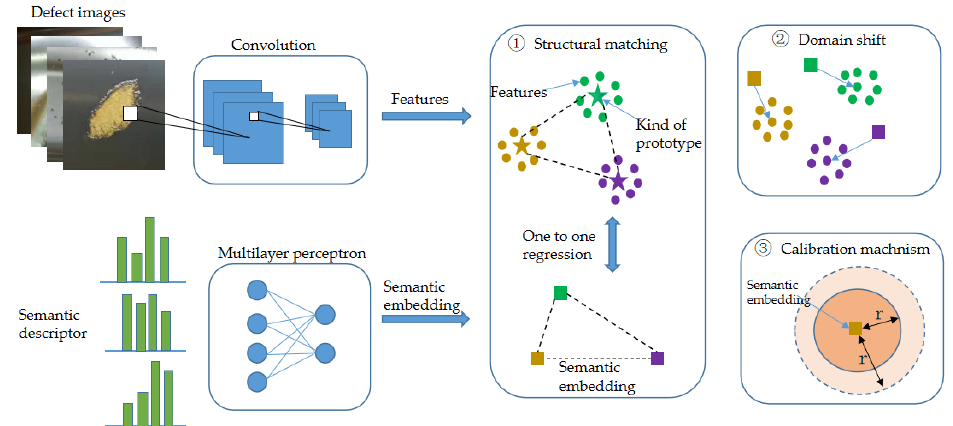
Figure 5. Generalized ZSR framework for wheel hub defect images.